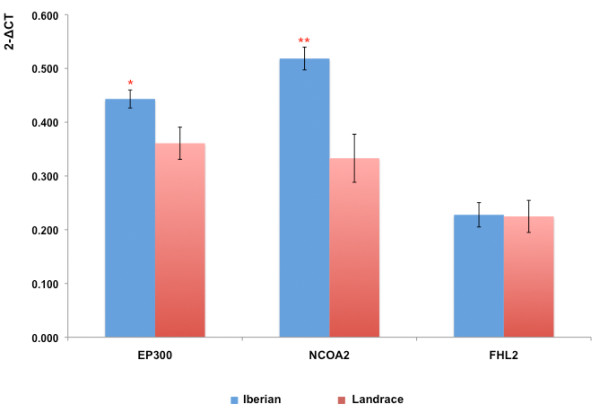
Results of the liver differential expression analysis comparing the best TF trio in the Iberian and Landrace breeds.